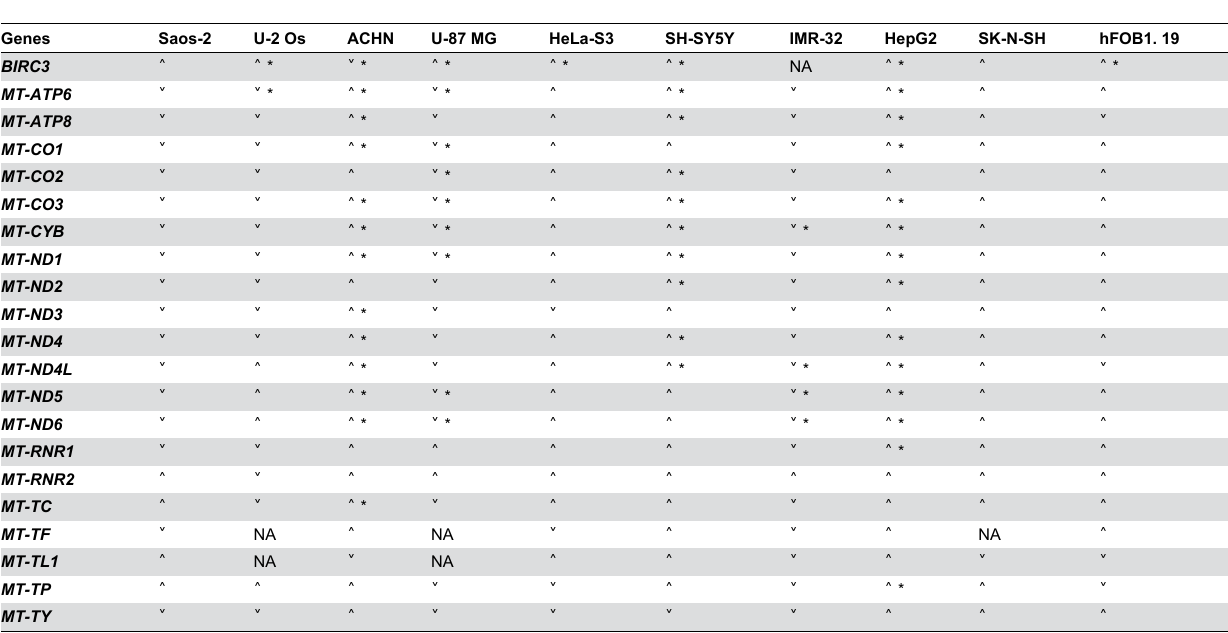
Table 2. Expression differences observed for BIRC3 and mitochondrially encoded